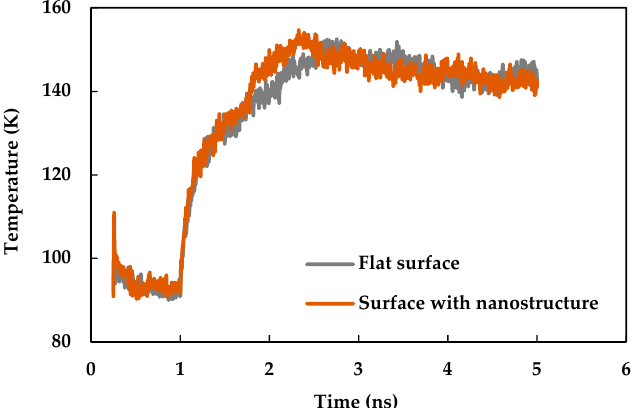
Figure 11. Comparison of temperature history of argon atoms for nano-structured surface with smooth surface.